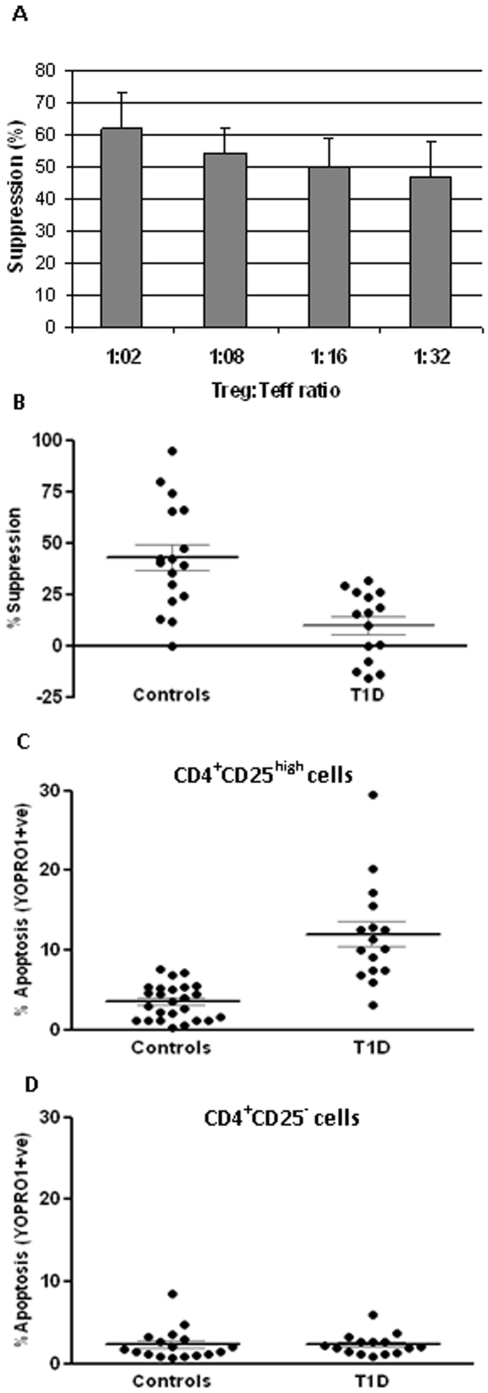
In T1D subjects, Tregs isolated from CD4+ T cells have reduced function and increased apoptosis.Standard in vitro suppression assay included 25,000 responder CD4+CD25− T cells that were set up as single culture as well as with CD4+CD25high T cells in co-culture, both with added 25,000 of irradiated PBMCs (as antigen-presenting cells) which were stimulated with aCD3-coated beads (1 µg/ml) for 5 days. Ratio of responder and CD4+CD25high T cells was varied. Suppressors were seeded with APC in separate wells to measure their own proliferation in respond to the same stimulation. Bars are mean±SEM of three independent observations. (B) Suppression potential of isolated CD4+CD25high T-cells measured by an in vitro proliferation assay in T1D (n = 17) and control (n = 15) subjects. A standardized suppression assay was performed with 2.5×104 CD4+CD25− effector T-cells (with 2.5×104 irradiated PBMC -5000rad) in co-culture with CD4+CD25high T-cells at a 1∶10 ratio (CD4+CD25high: CD4+CD25−), stimulated with aCD3 coated beads (1 ug/ml, 3 beads/per cell). Apoptosis results following YOPRO-1/7AAD staining for (C) CD4+CD25high (T1D: n = 16, controls: n = 25) and (D) CD4+CD25− T-cells (T1D: n = 15, controls: n = 17) are both presented as % apoptotic (YOPRO1+ve) amongst live cells (7AAD–ve).